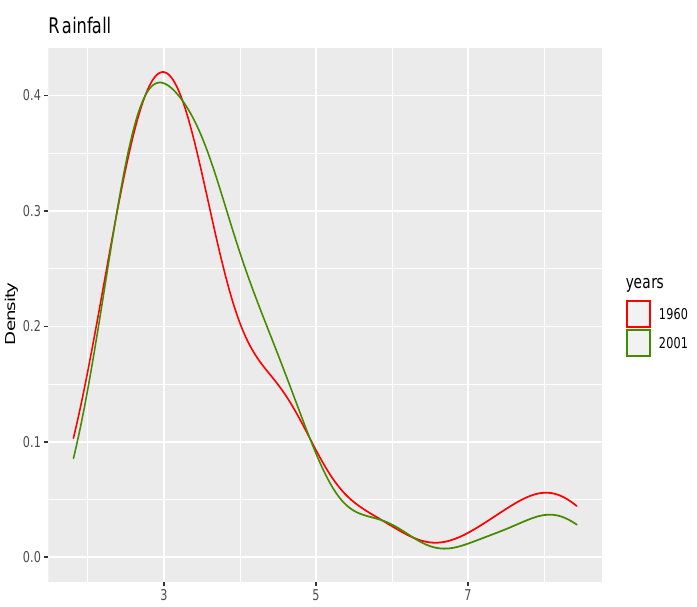
Figure 3. The comparison of rainfall distributions, 1960 vs. 2001.